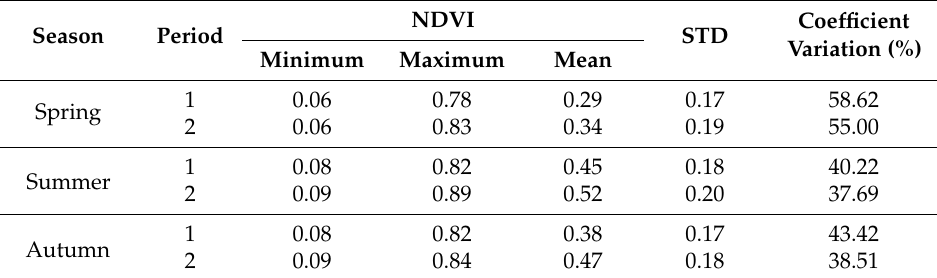
Table 2. Statistical characteristics of seasonal NDVI on the Loess Plateau.